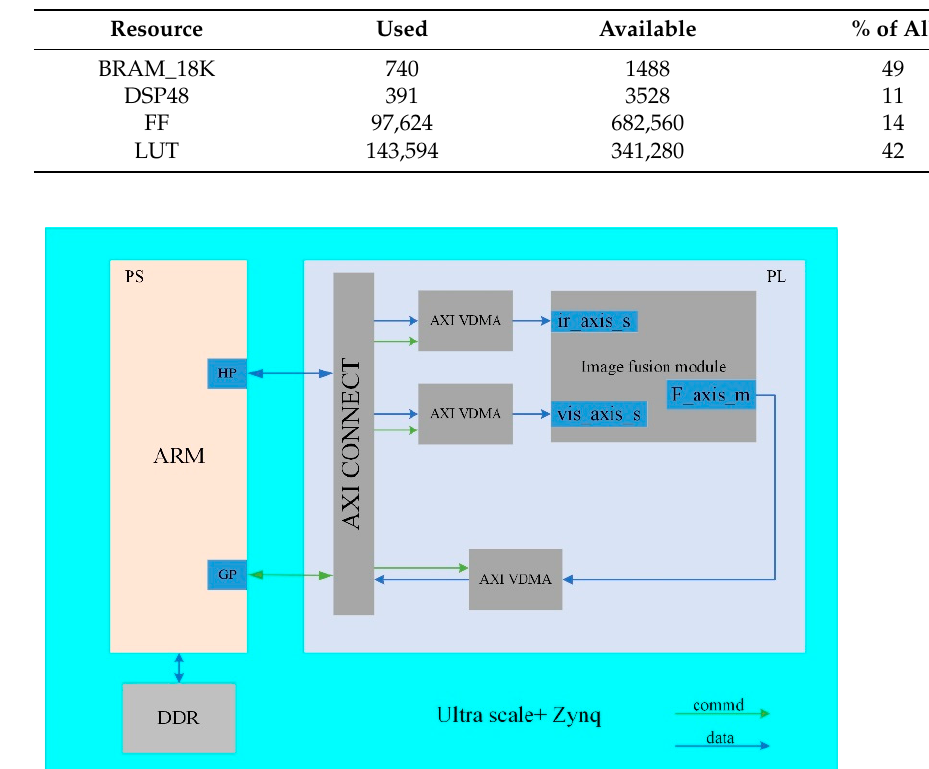
Figure 9. System block diagram for the FPGA implementation.